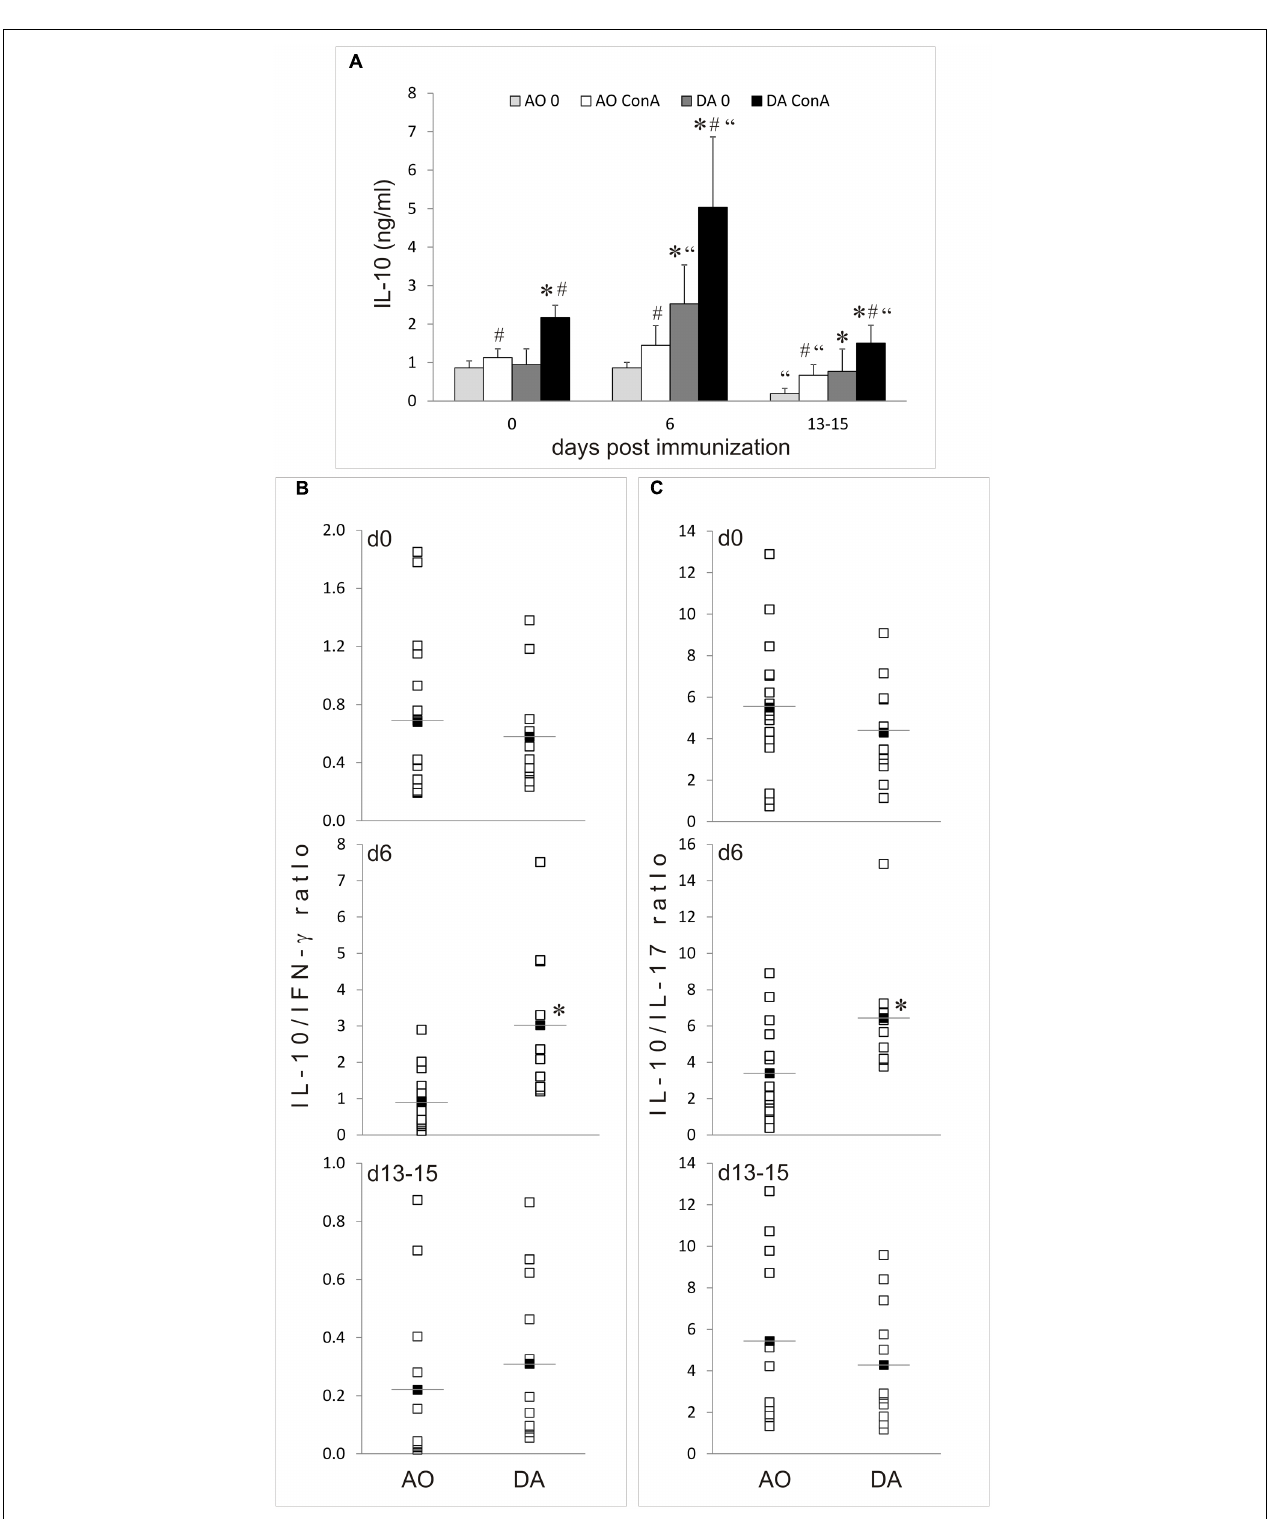
Frontiers in Microbiology |